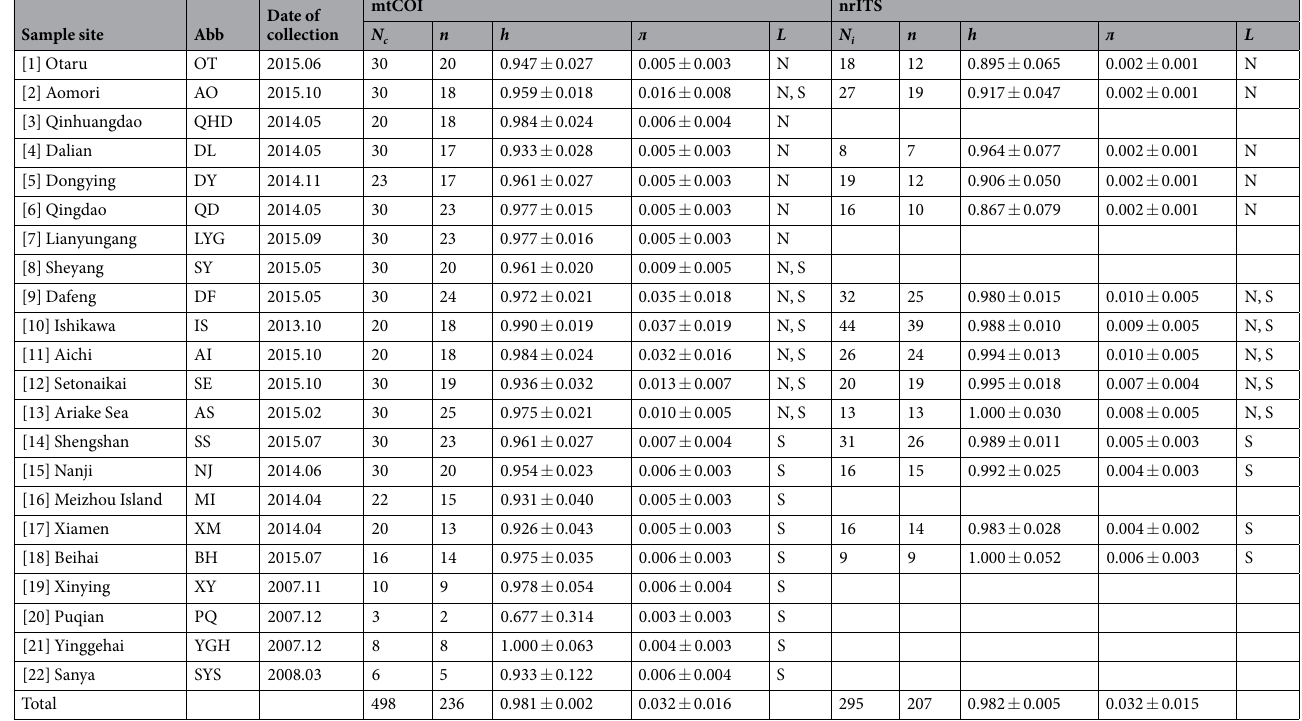
Table 1. Sample information and molecular diversity indices for O. oratoria . Abb., abbreviation of locality; N c , number of sequenced individuals; n , number of haplotypes; N i , number of clones; h , haplotype diversity; л , nucleotide diversity; L , lineage found in each